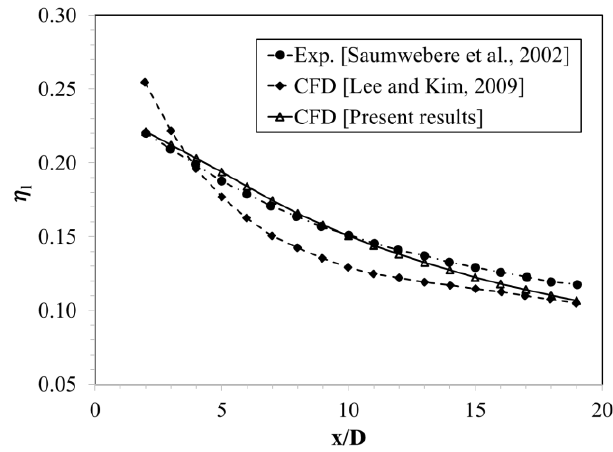
Figure 7. Numerical validation.